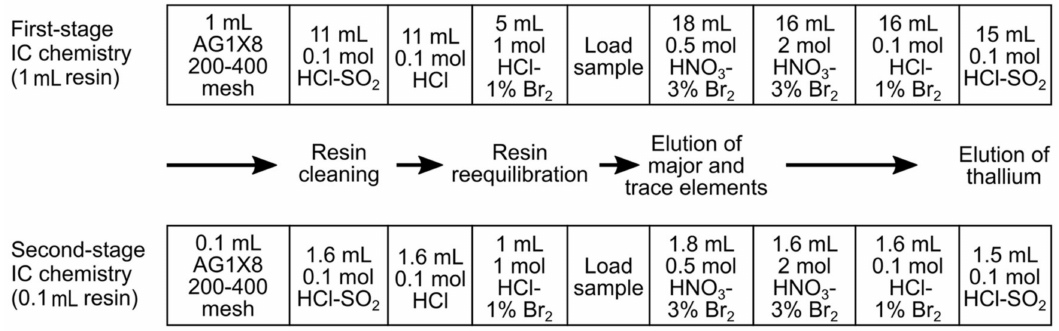
Figure 3. A flowchart showing the Tl separation column chromatography process, modified after